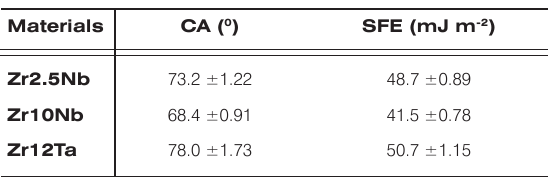
Table 4. The contact angle and surface free energy for the three alloys.